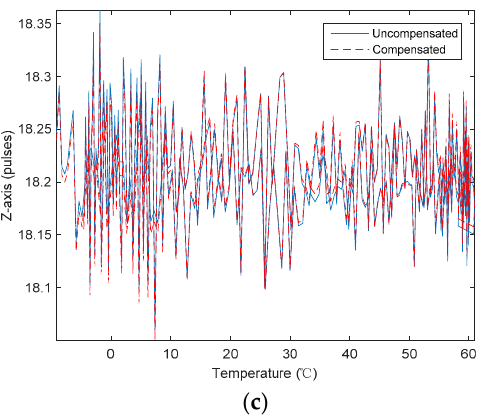
Figure 6. Bias of RLG before and after the static temperature model compensation. ( a ) X -axis of gyro; ( b ) Y -axis of gyro; ( c ) Z -axis of gyro.